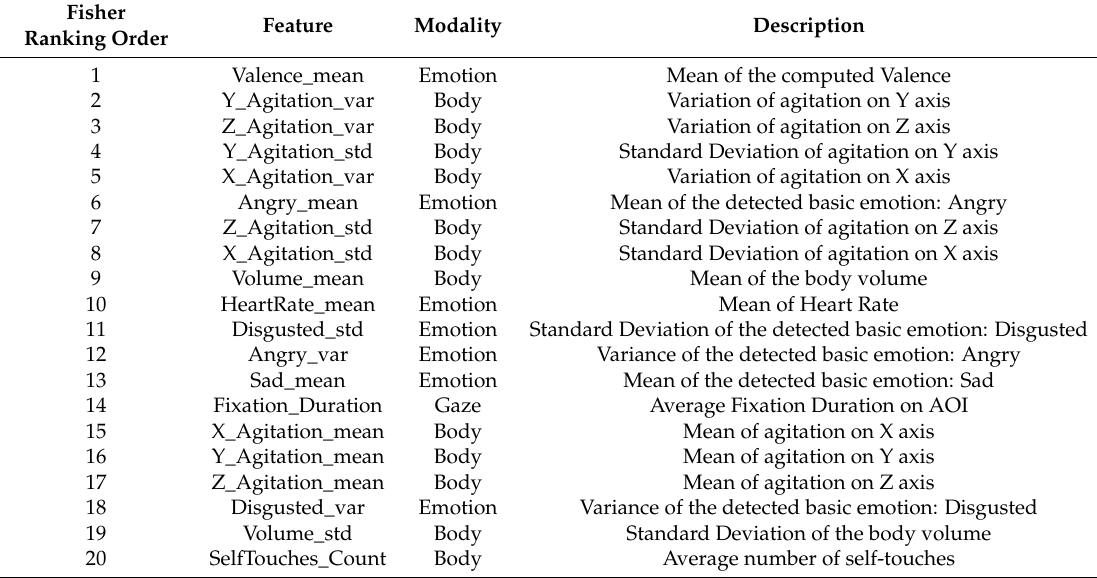
Table 6. Ordered list of the 20 most relevant features generated by Fisher algorithm [35]. Fisher Ranking